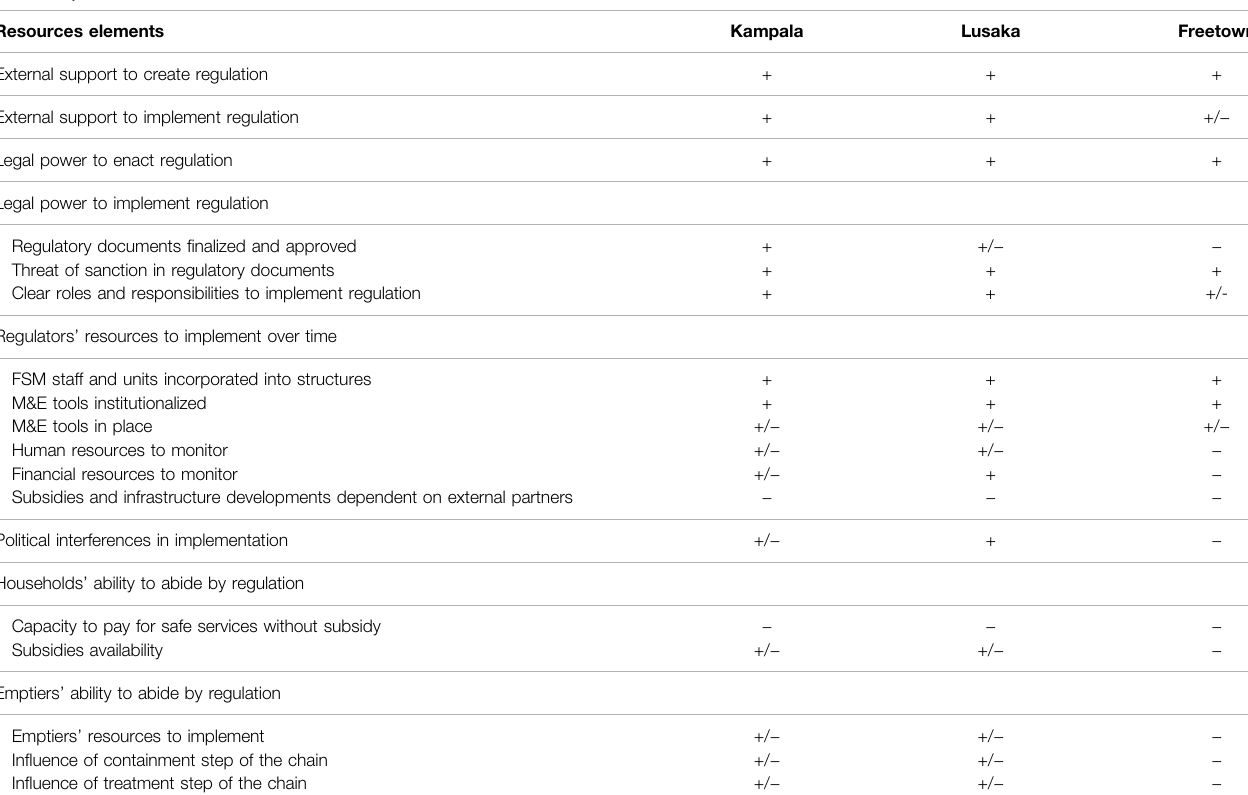
TABLE 6 | Barriers to and enablers for resources from interviews.